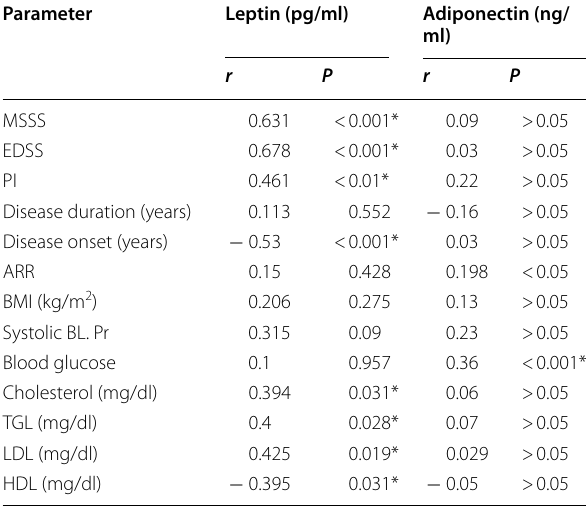
Table 4 Correlation between serum leptin levels and adiponectin with